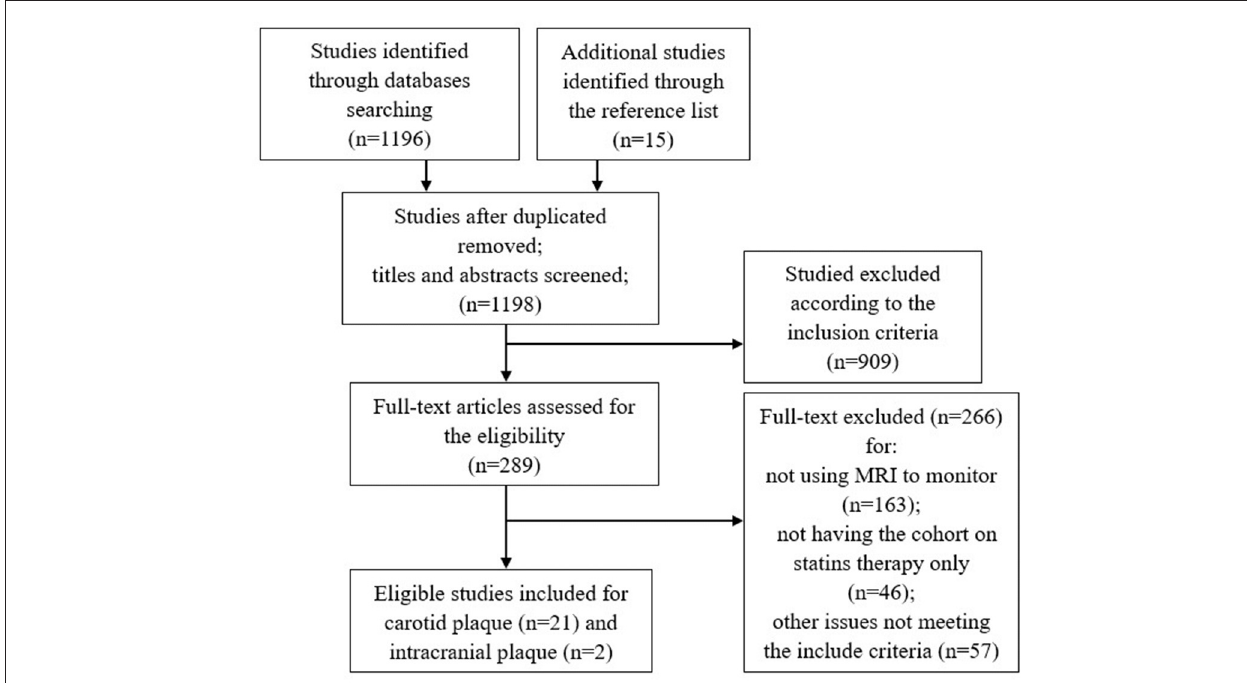
FIGURE 1 | Flow diagram of literature screening and selection process.